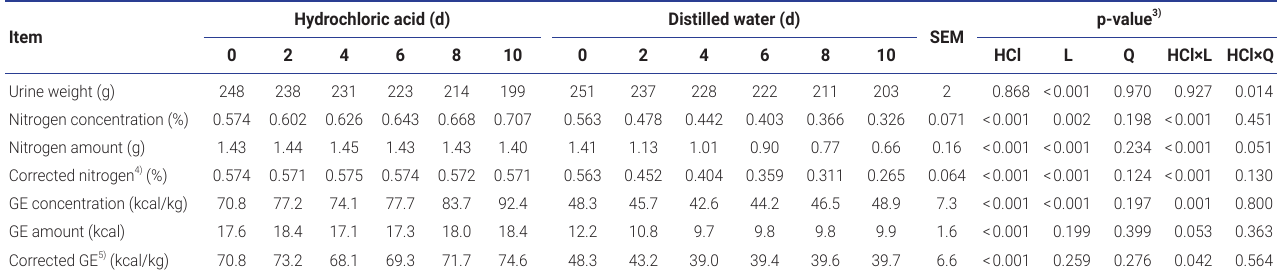
Table 1. Effects of hydrochloric acid supplementation to pig urine on nitrogen and gross energy (GE) contents at room temperature for 10 days, Exp. 1